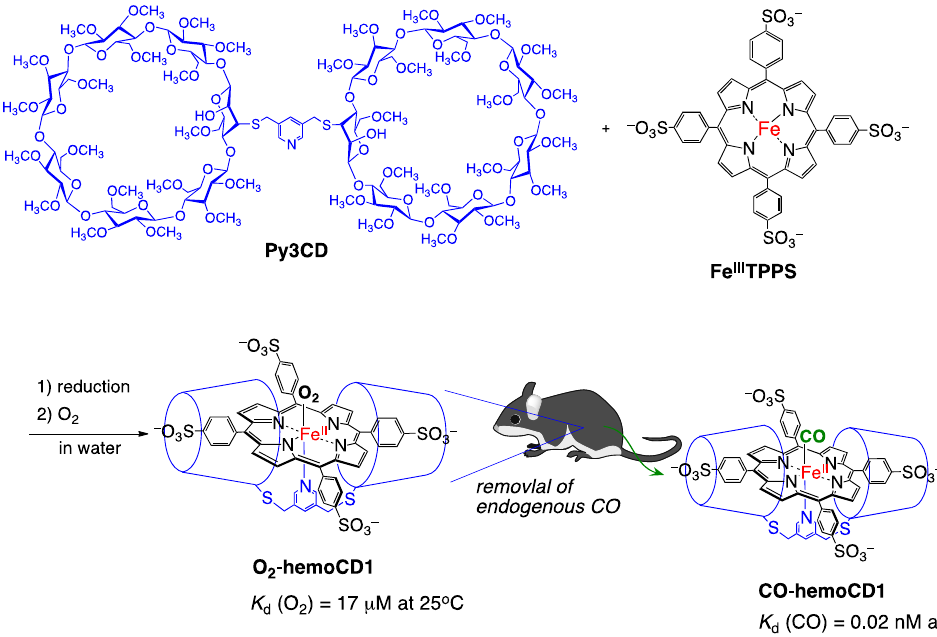
Figure 2. The structure of a CO-scavenging agent, hemoCD1, a 1:1 supramolecular inclusion complex of an ironporphyrin (FeTPPS) and a per- O -methylated cyclodextrin dimer (Py3CD). HemoCD1 is used for selective removal of endogenous CO in mice via the ligand exchange reaction of O 2 with CO. The binding affinity for CO ( P 1/2CO = 0.000015 Torr) is much higher than that for O 2 ( P 1/2O2 = 10 Torr) 34 . The components of Fig. 2 were drawn using